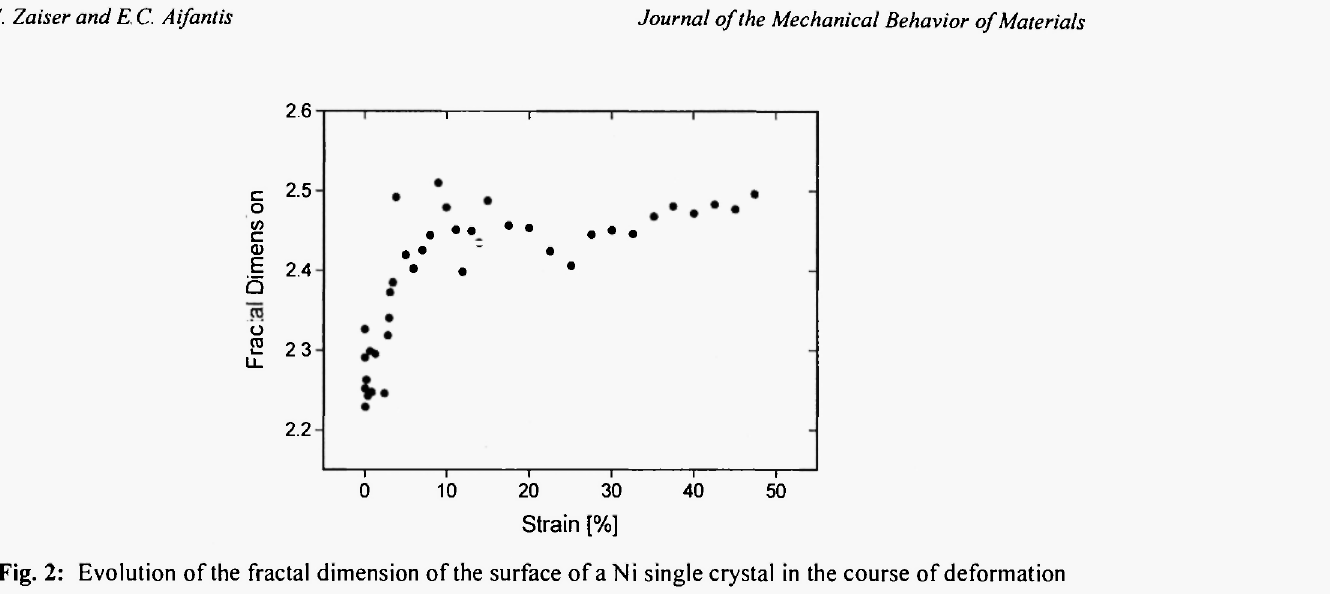
Fig. 2: Evolution of the fractal dimension of the surface of a Ni single crystal in the course of deformation